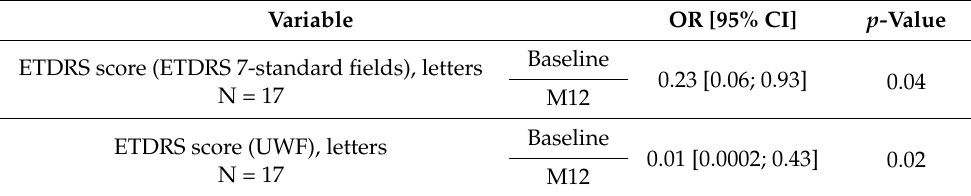
Table 2. Summary of the main results.